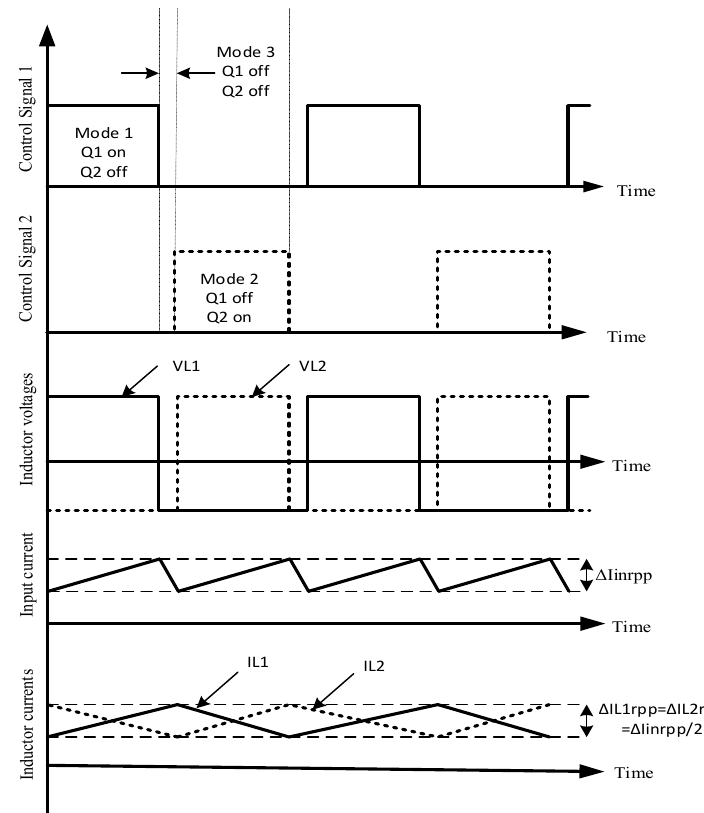
Figure 6. Voltage and currents waveforms of the interleaved CCM (continues-current-conduction mode) PFC topology.